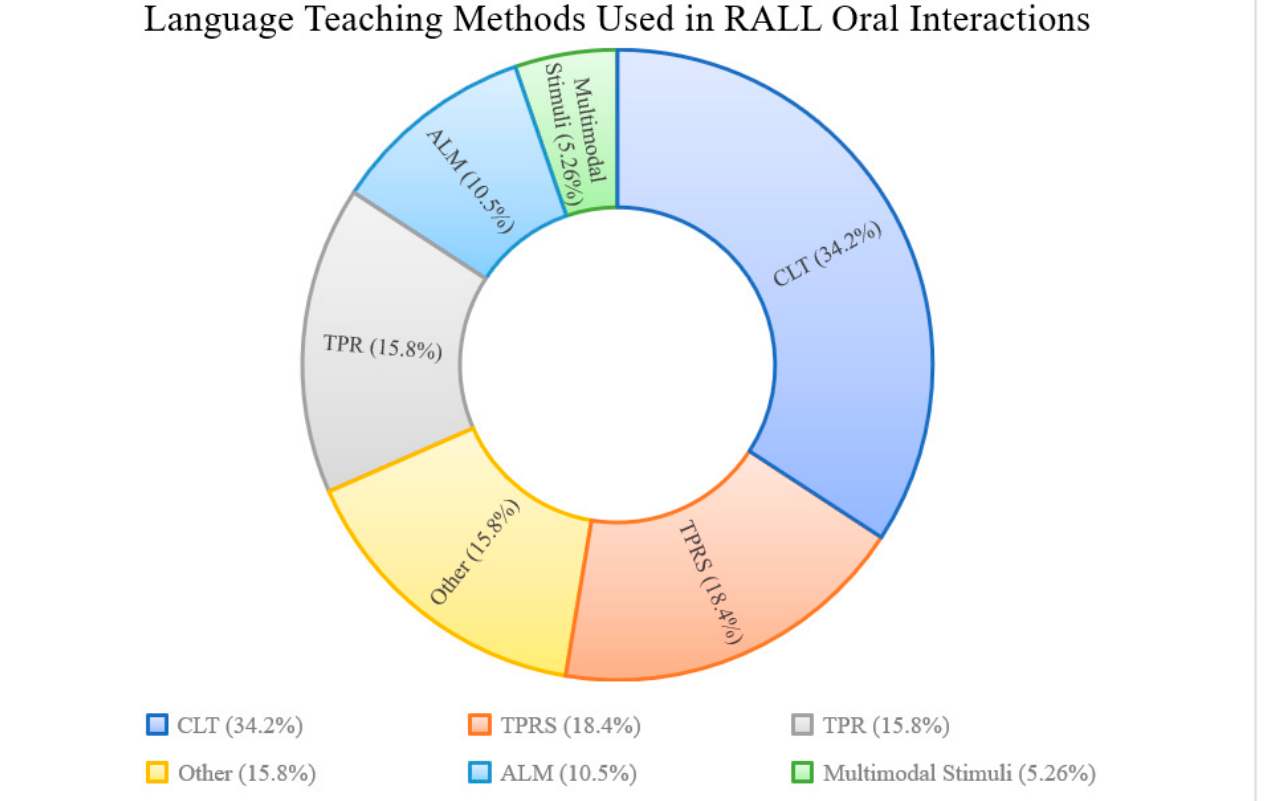
Figure 2. Language teaching methods in RALL oral interactions. NOTE: CLT = Communicative Language Teaching. TPRS = Teaching Proficiency through Reading and Storytelling. TPR = Total Physical Response. ALM = Audiolingual Method.